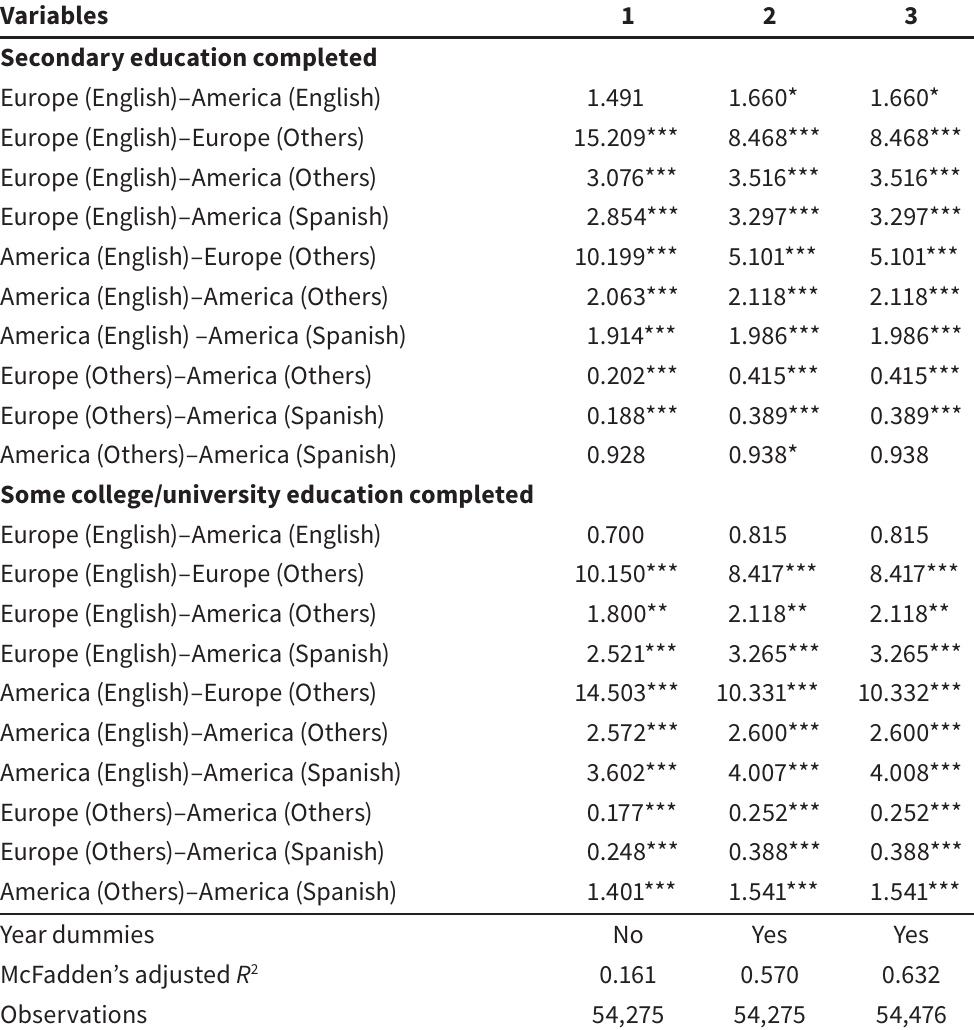
Location choice: destination countries classified by languages and continents